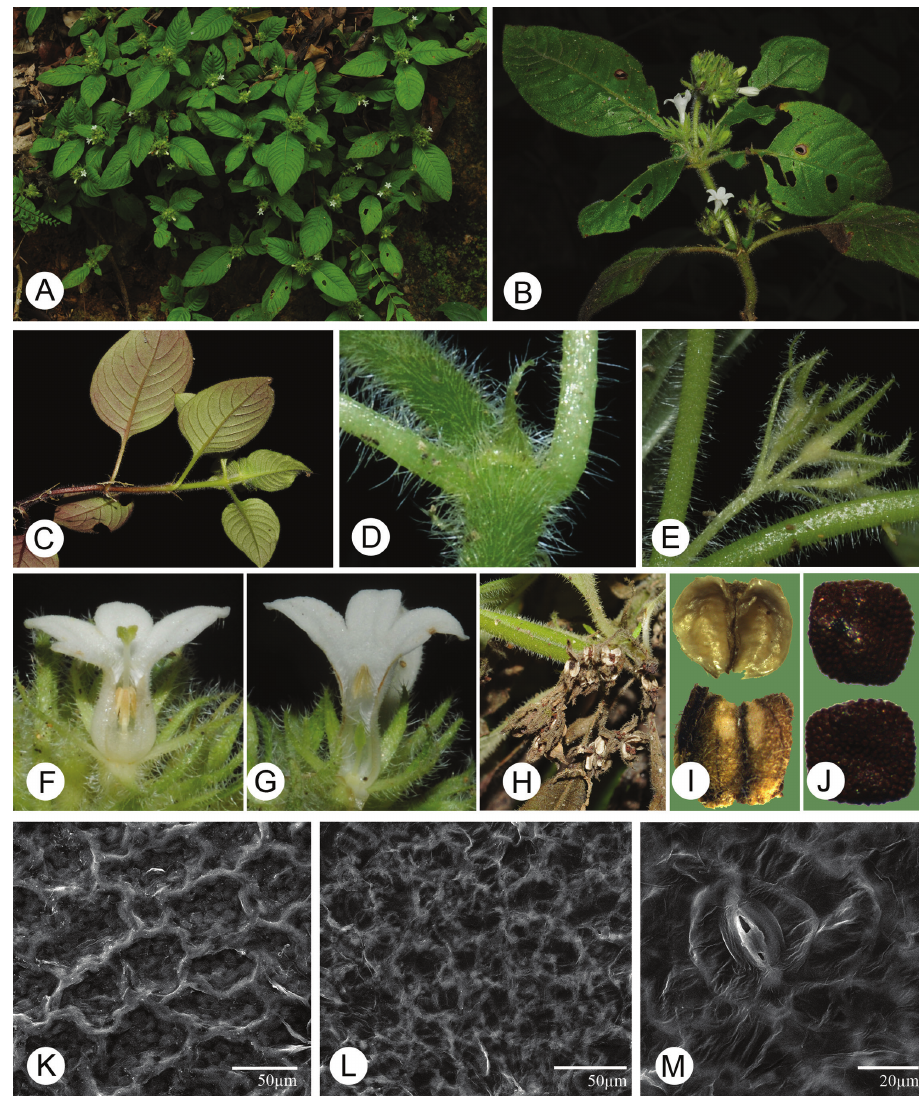
Figure 1. Morphological characters of Spiradiclis longanensis . A Habit B Flowering branch, showing the position of inflorescence C Vegetative branch, showing the linear stipules, hairy leaves and venation pattern D Hairy stems, petioles, and stipules E Hairy young infructescence, showing the linear bracts and calyx lobes F, G Longitudinally dissected long- and short-styled flower, respectively, showing the positions of anthers and styles H infructescence, showing the dehiscent mature capsules I Capsule valves in adaxial (up) and abaxial sides (low), showing the dehiscence pattern J Seeds in adaxial (up) and abaxial sides (low) under stereoscope, showing the hilum and papillate surface K, L, M Morphology of adaxial, abaxial leaf epidermis, and stomatal apparatus under SEM, respectively (from R.J. Wang & Q. Liao 2592 ). Photos by Ruijiang